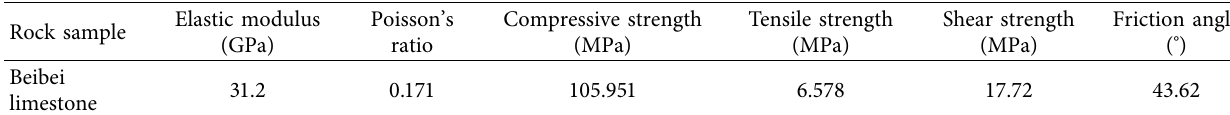
Table 1: Basic mechanical parameters of the rock.